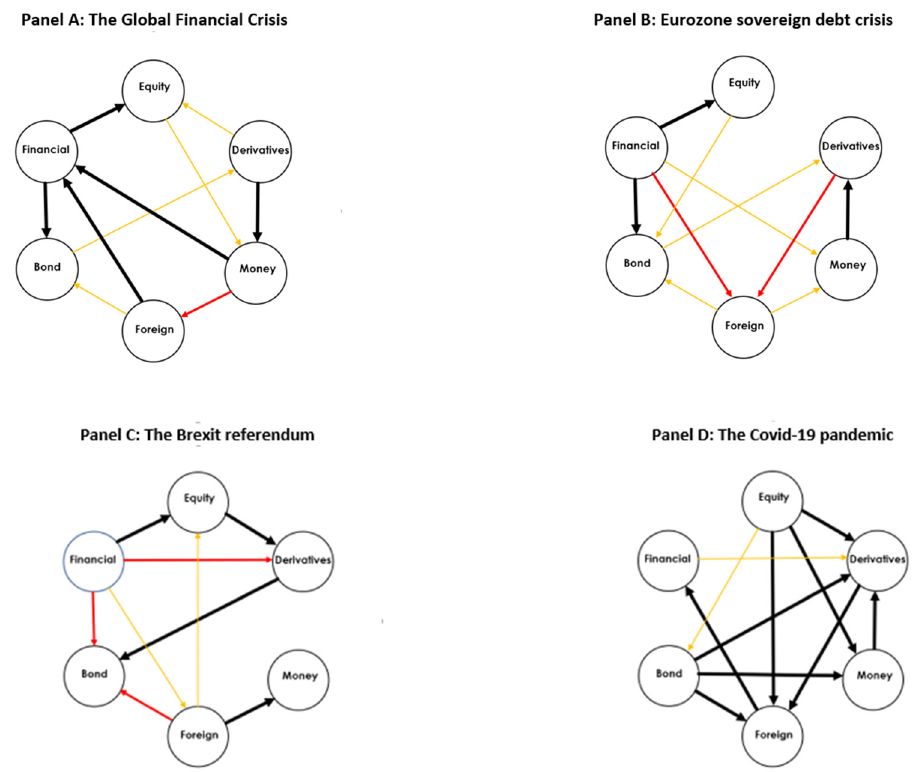
Figure 5. Network diagram of pairwise net directional stress spillovers on certain critical episodes. Note: We show the most important net directional connections among the six market stress indices under study for four critical episodes. Panel ( A ) illustrates the period of the global financial crisis (August 2007 to October 2008), panel ( B ) shows the Eurozone sovereign debt crisis (April 2010 to August 2011), panel ( C ) shows the global financial turmoil following the Brexit referendum (June to October 2016), and panel ( D ) shows the outbreak of the COVID-19 pandemic (March to June 2020). Black, red, and orange links (black, grey, and light grey when viewed in greyscale) correspond respectively to the 90th, 80th, and 70th percentiles of all net pairwise directional connections.